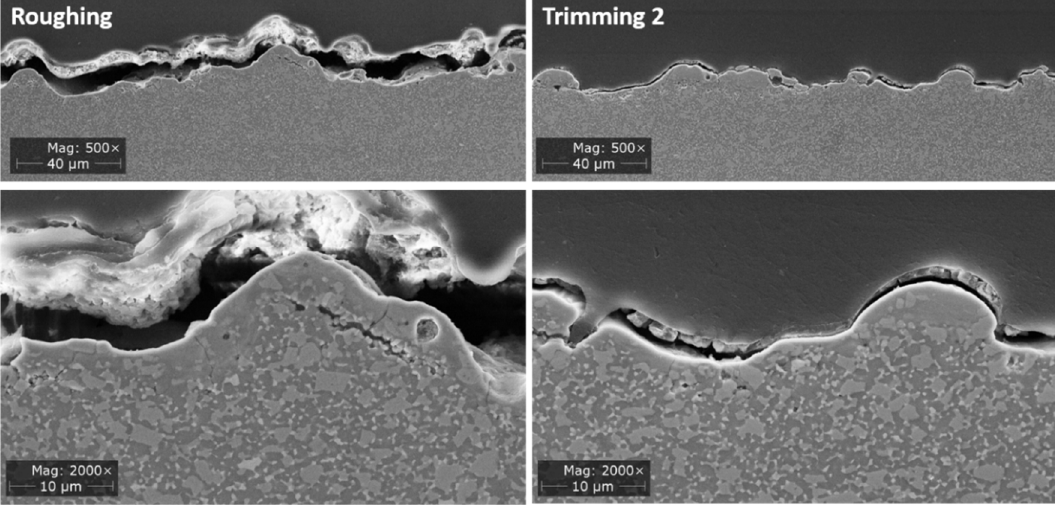
Figure 8. SEM images showing cross sections of ZTA-TiN surfaces ED-machined with different parameter sets (left roughing, right trimming 2).